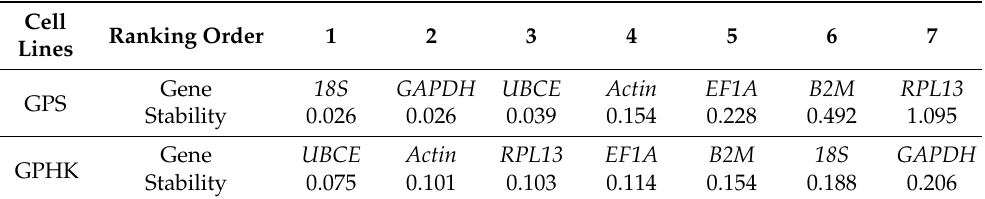
Table 4. The expression stability of housekeeping gene candidates in GPS and GPHK cells under normal conditions assessed by NormFinder.